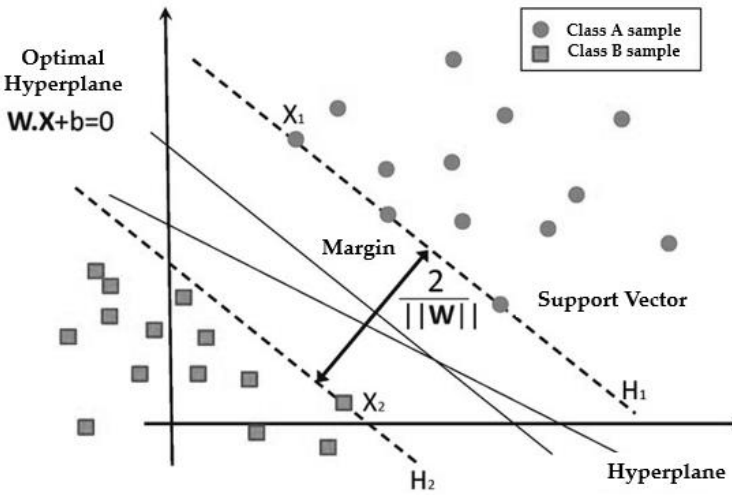
Figure 3. Classification of data by support vector machine (SVM).